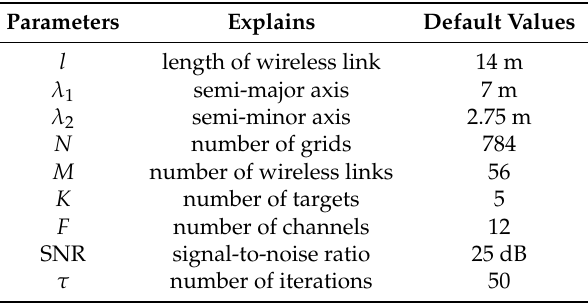
Table 1. Default values of simulation